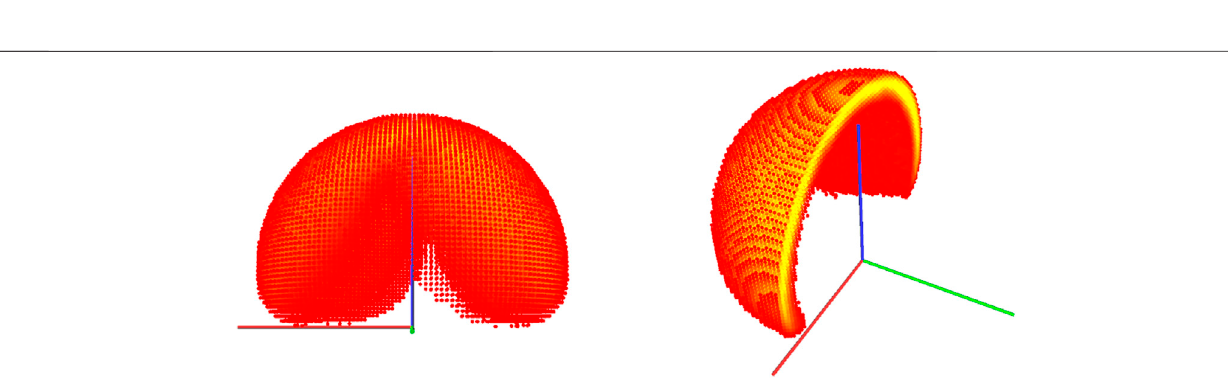
FIGURE11 | Capabilitymap spanned from the failure diagram in Figure 10top , and cross-section of thesamemap. It corresponds tothe post-failure return-safe workspace for all pre-image manifolds.